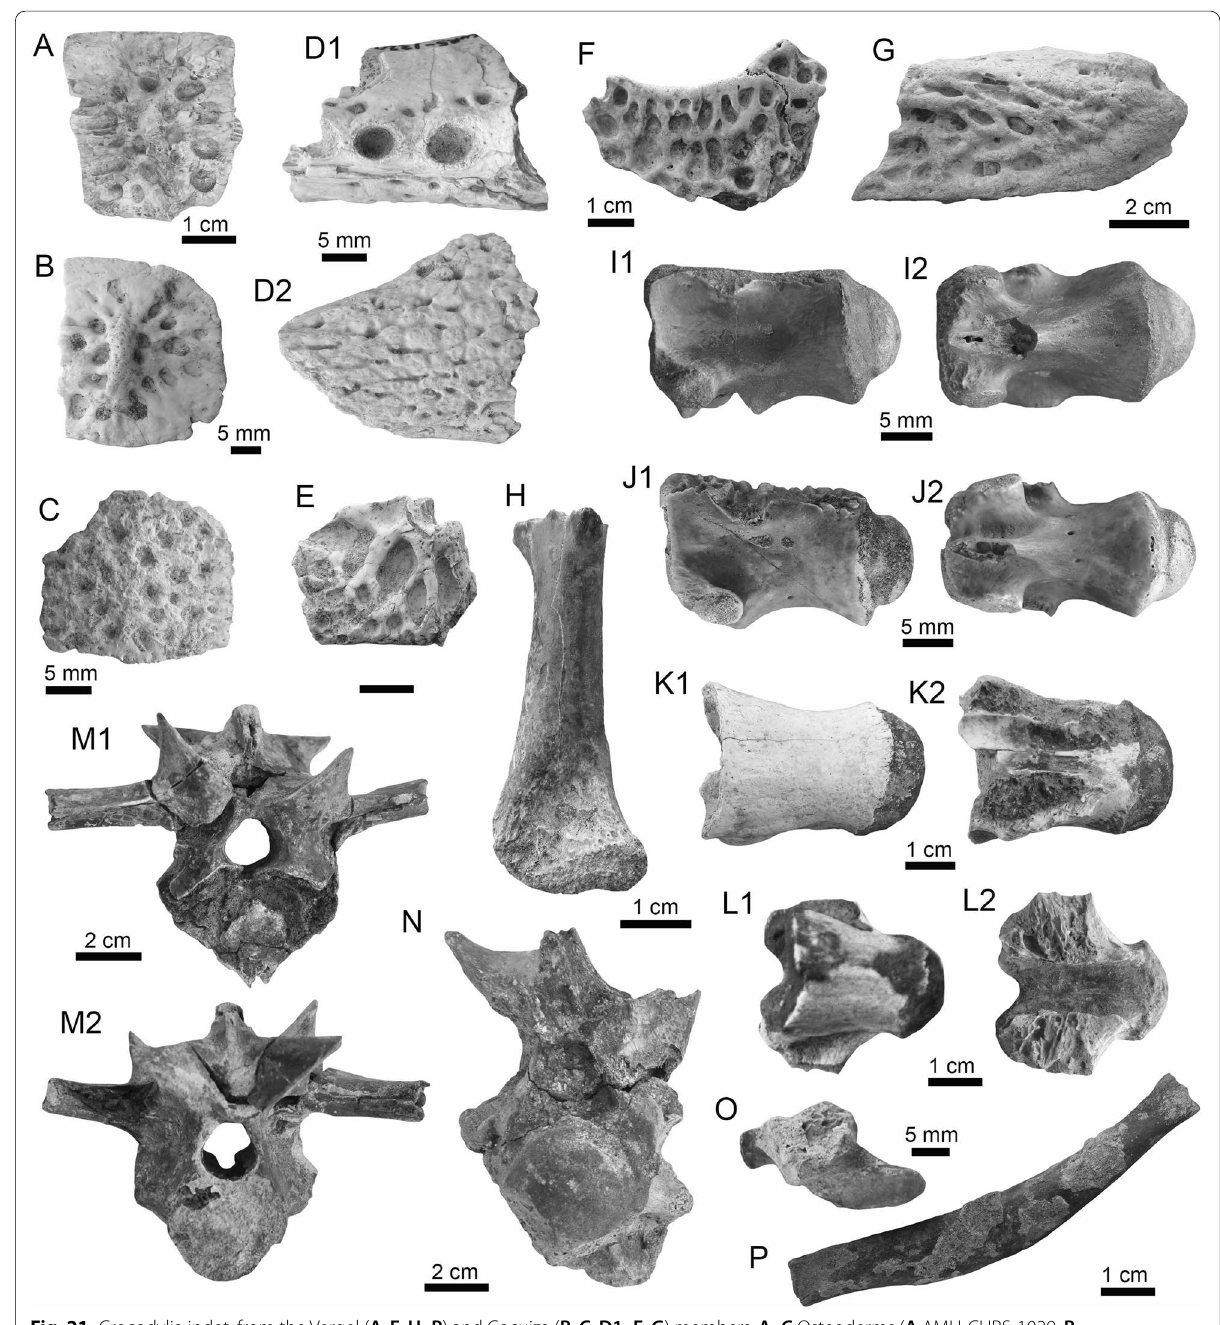
Fig. 21 Crocodylia indet. from the Vergel ( A , F , H – P ) and Cocuiza ( B , C , D1 – E , G ) members. A – C Osteoderms ( A AMU‑CURS‑1029, B AMU‑CURS‑1314, and C AMU‑CURS‑1316). D1 , D2 Portion of a left dentary (AMU‑CURS‑1320). E Portion of either skull or lower jaw (AMU‑CURS‑1321). F Fragment from the skull roof (AMU‑CURS‑1200). G Posterior part of a surangular (AMU‑CURS‑1309). H Humeral shaft (AMU‑CURS‑743). I1 – N Vertebrae ( I1 , I2 AMU‑CURS‑21, J1 , J2 AMU‑CURS‑826, K1 , K2 AMU‑CURS‑1030, L1 , L2 AMU‑CURS‑578a and M1 – N AMU‑CURS‑1062). O Isolated prezygapophysis (AMU‑CURS‑1236). P Rib fragment (AMU‑CURS‑578b). Views: anterior ( M1 ), dorsal ( D1 , F , K2 , L2 , O ), external ( A – C ), left lateral ( D2 , I1 , J1 , G ), posterior ( M2 – N ), ventral ( H , I2 , J2 – K1 , L1 ), and indet. ( E , P